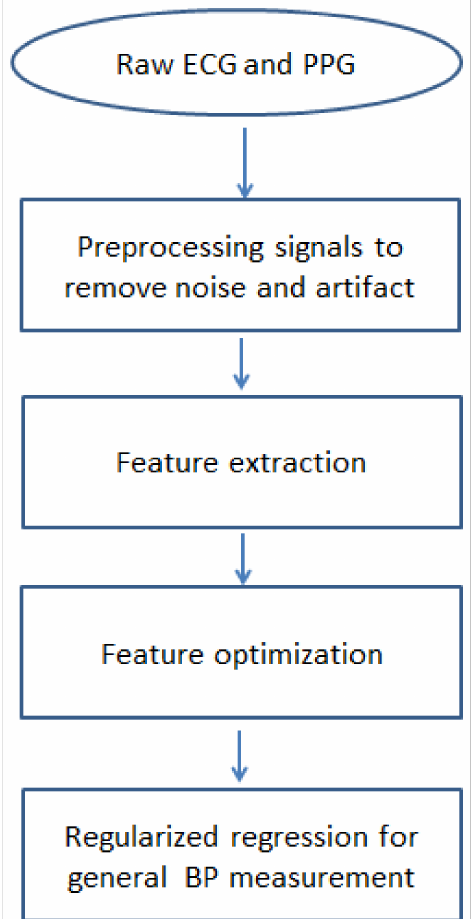
Figure 1. Diagram for model used for cuffless BP